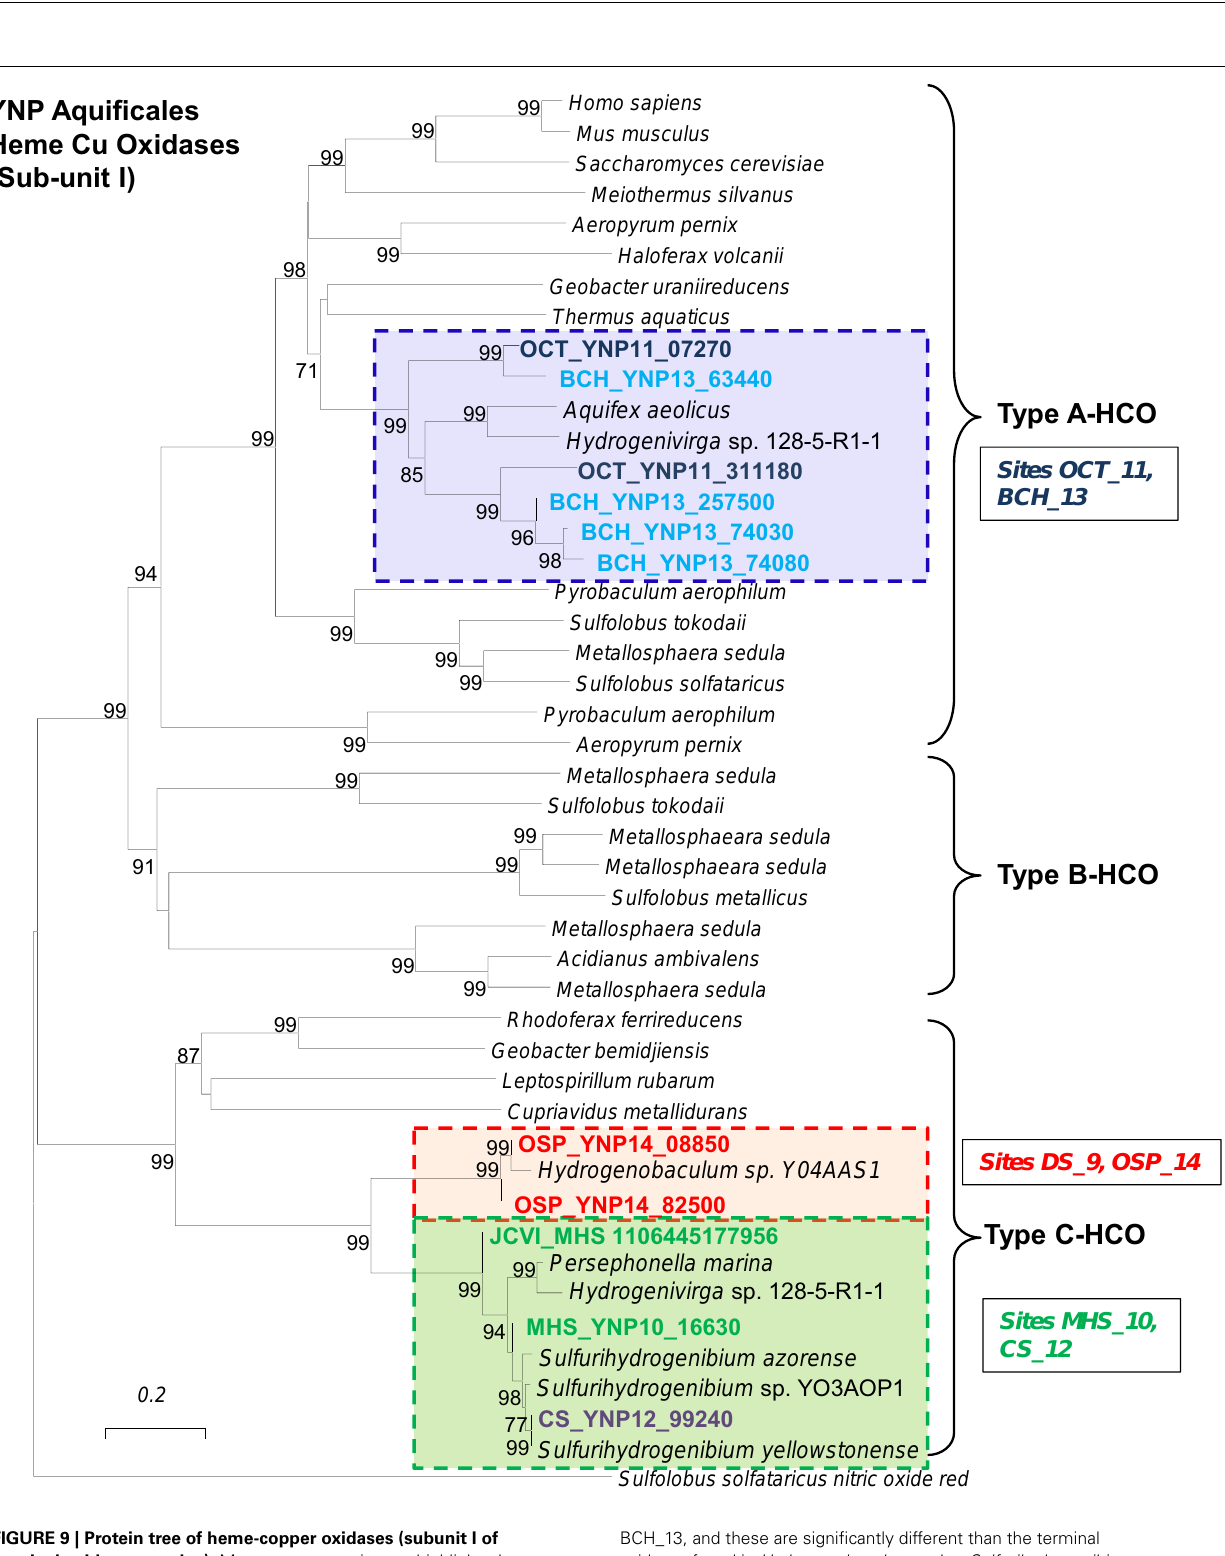
BCH_13, and these are significantly different than the terminal oxidases found in Hydrogenobaculum and or Sulfurihydrogenibium from sites DS_9, OSP_14, MHS_10 and CS_12 (neighbor-joining tree constructed using nitric oxide reductase (NorB) as the out group; 1000